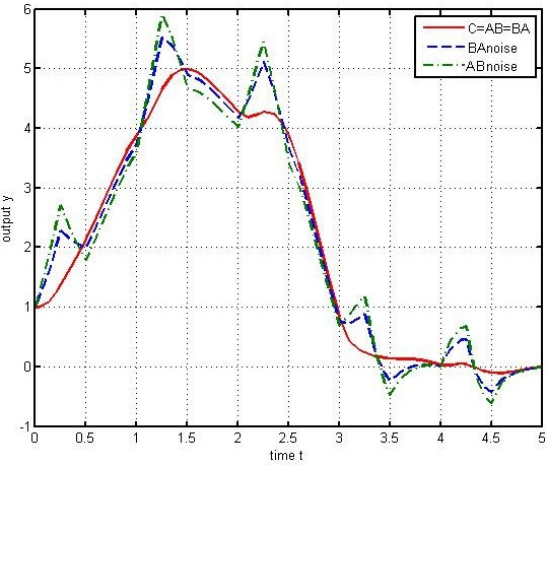
Fig. 6. The outputs of the system C and its cascade synthesis AB and BA with and without